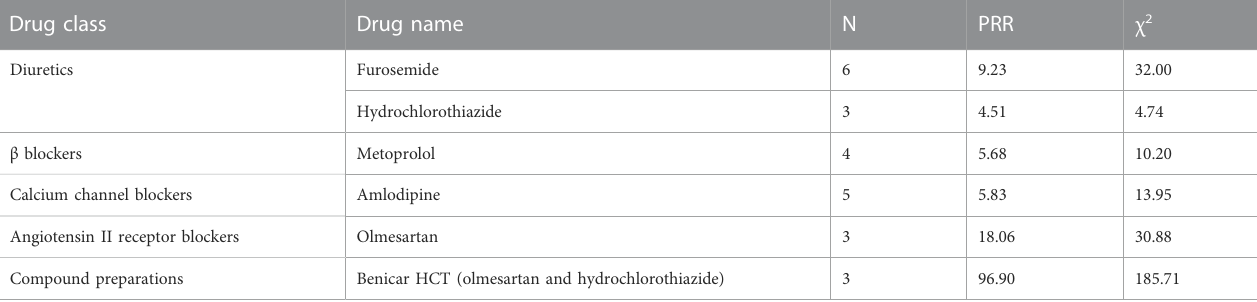
TABLE 6 Antihypertensive drugs with positive signals for urate